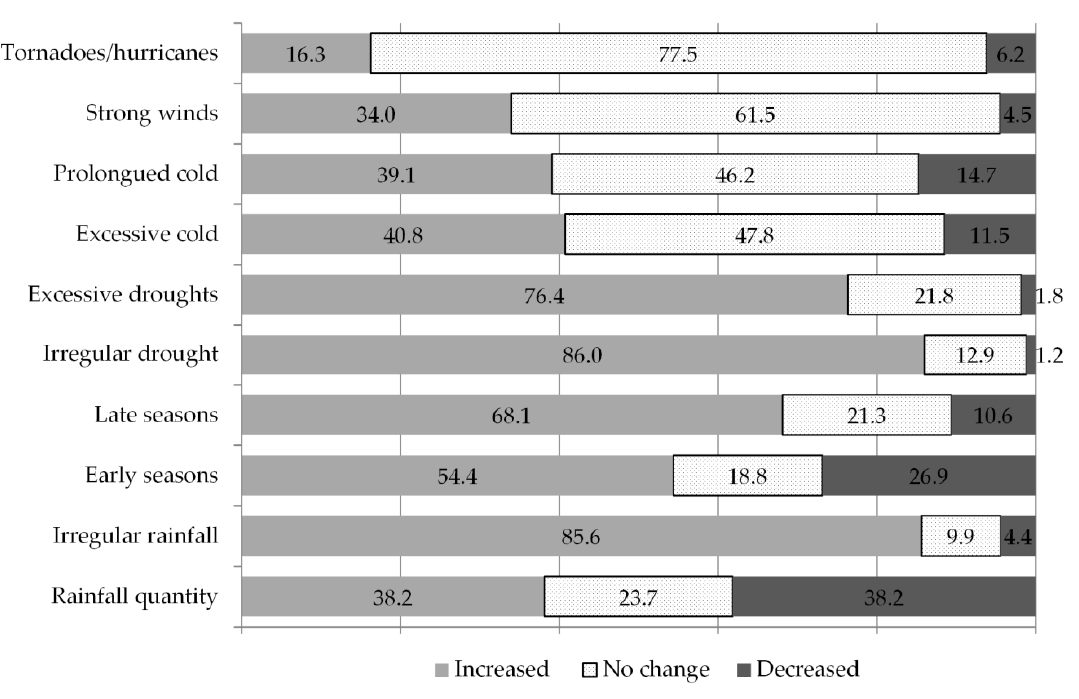
Figure 1. Plant breeders’ perceptions about weather patterns observed in their regions. Numbers on or next to the bars represent percentages over the total responses.